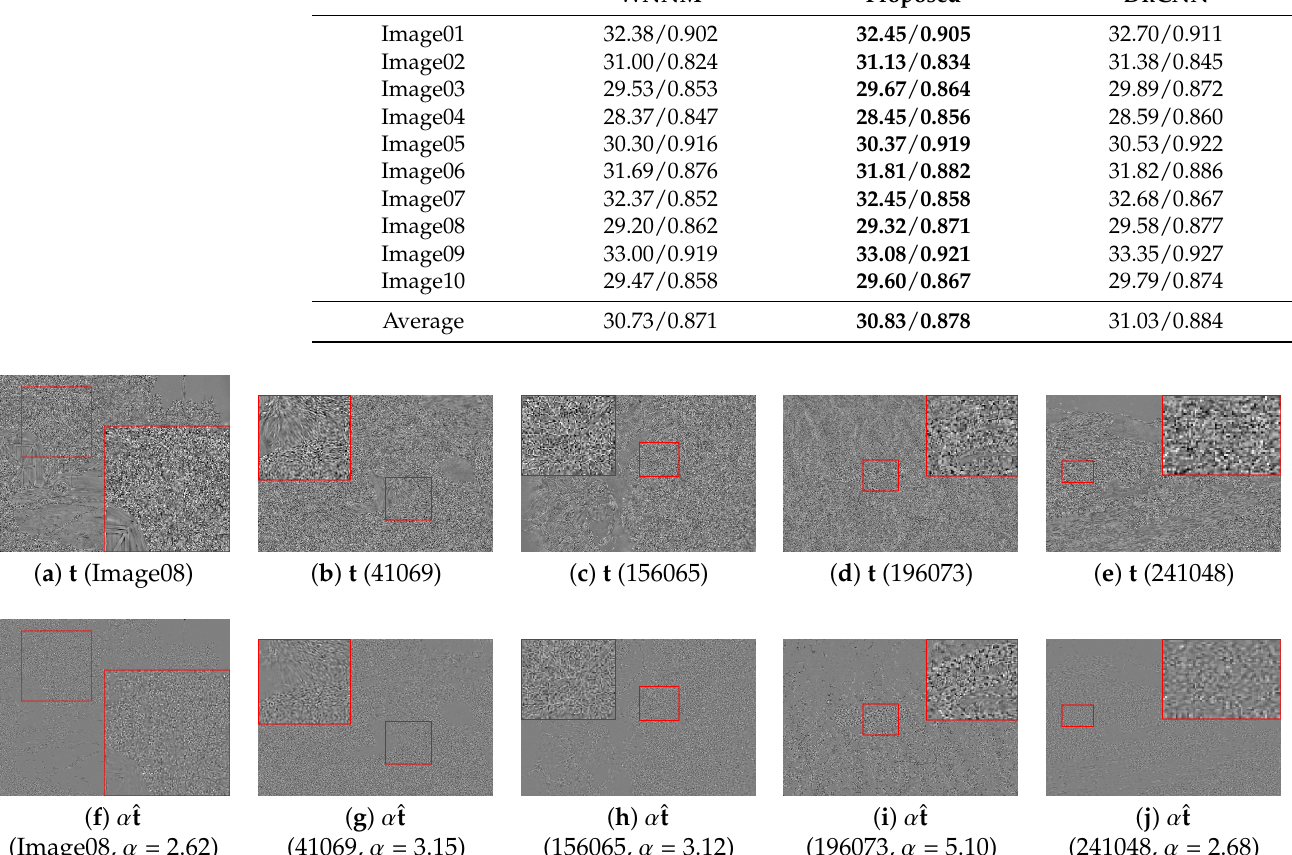
Figure 5. True texture t and estimated texture ˆ t of the proposed method. The pixel value of each image is multiplied by a factor of 3.